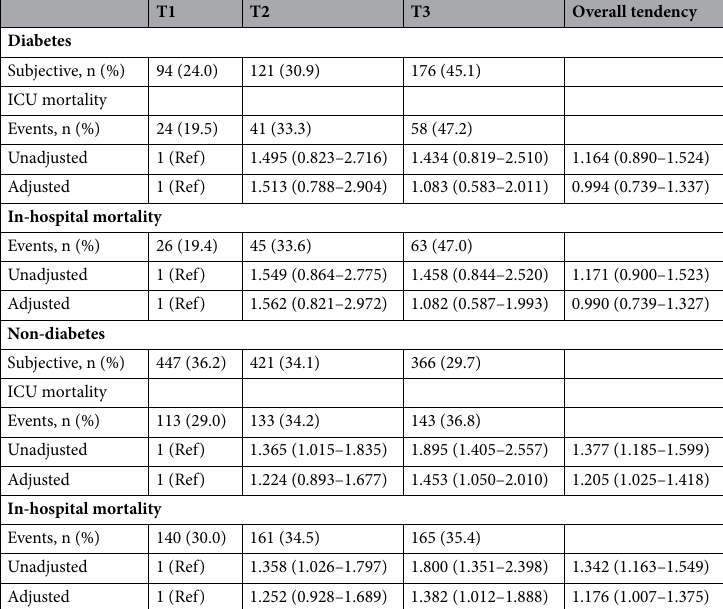
Table 3. Odds ratios (OR) and 95% confidence intervals (CI) for mortality associated with 24-hVBGCV in diabetes and non-diabetes groups. Adjusted for age, sex, ethnicity, SOFA score, obesity, infection, diabetes, chronic pancreatitis, heart failure, renal failure, use of insulin. OR was for ICU mortality and hospital mortality. 24-hVBGCV coefficient of variation of 24-h venous blood glucose, ICU intensive care unit, SOFA sequential organ failure